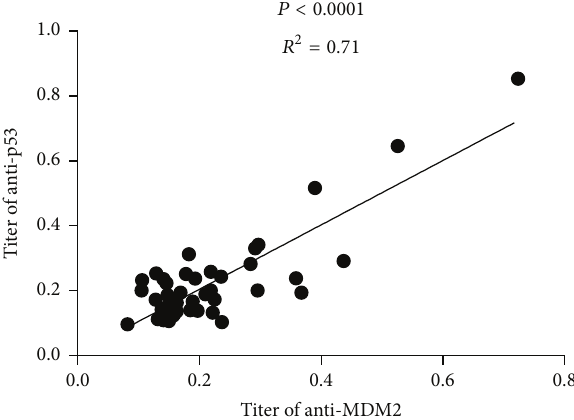
Figure 5: Correlation between anti-MDM2 and anti-p53 antibodies in SLE patients. A positive correlation between the titers of anti-MDM2 and anti-p53 antibodies was found in 43 SLE patient